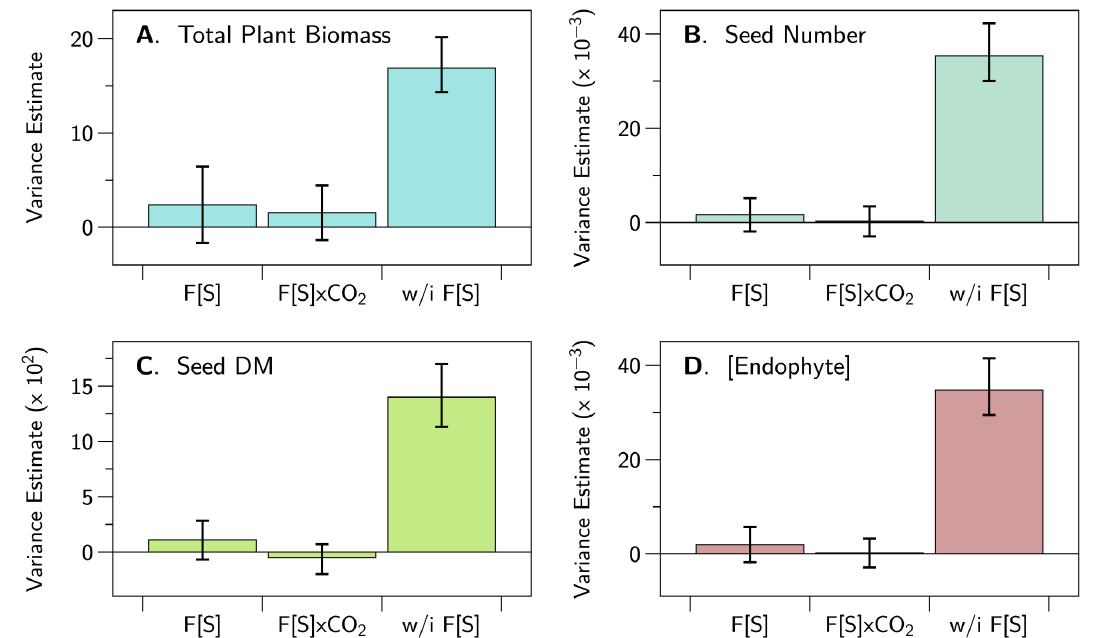
Figure 2. Plant growth responses—random effects. Shown are the variance estimates for the random effects. “F[S]” denotes the variance between maternal families nested in endophyte strain. ‘w/i F[S]’ denotes the variance within maternal families nested in strain. Variation between families is considerably less than variation within families, indicating no evidence of genetic incompatibility between host plants and endophyte strains. The units for the variances are: ( A ) ( g DM/plant ) 2 , ( B ) ( #/plant ) 2 , ( C ) ( g DM/plant ) 2 , ( D ) ( copies/ng gDNA ) 2